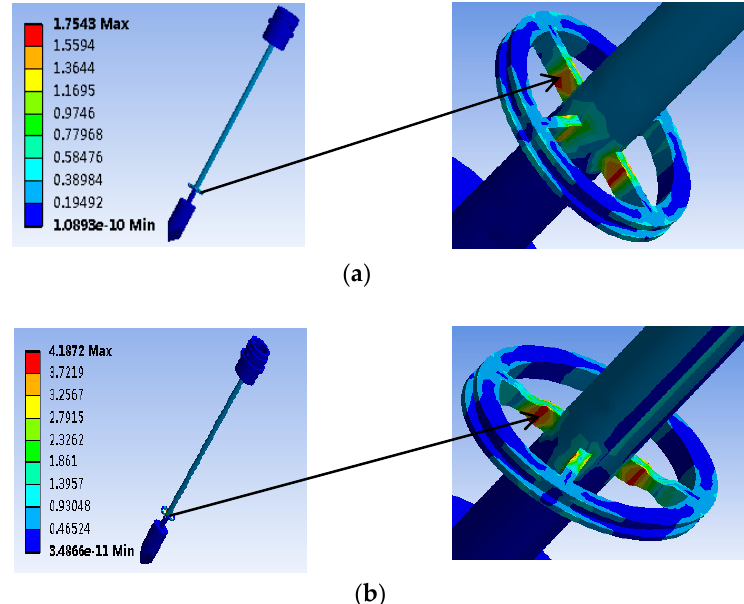
Figure 5. Simulation result: ( a ) Traditional elastic beam; ( b ) New type of elastic